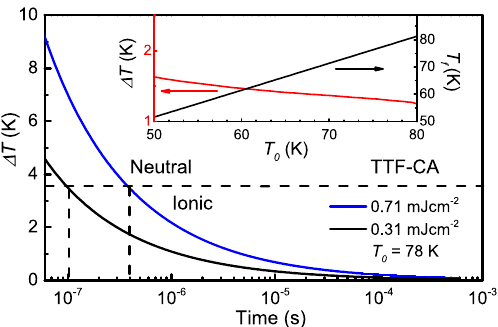
Figure 27. Time-dependent behavior of the surface temperature of TTF-CA, determined from Equation (9), after irradiation with the lowest and highest laser intensity at T 0 = 78 K. The surface temperature drops below T NI after 500 ns and remains low (highlighted by the black dashed vertical line). Therefore, any thermally induced effect can be excluded as the origin of the made spectral observation since it would be far below our time resolution. The detail shows the absolute change (black) and the relative (red curve) temperature modification, T f and ∆ T , below T NI derived from Equation (8), respectively. Adapted from